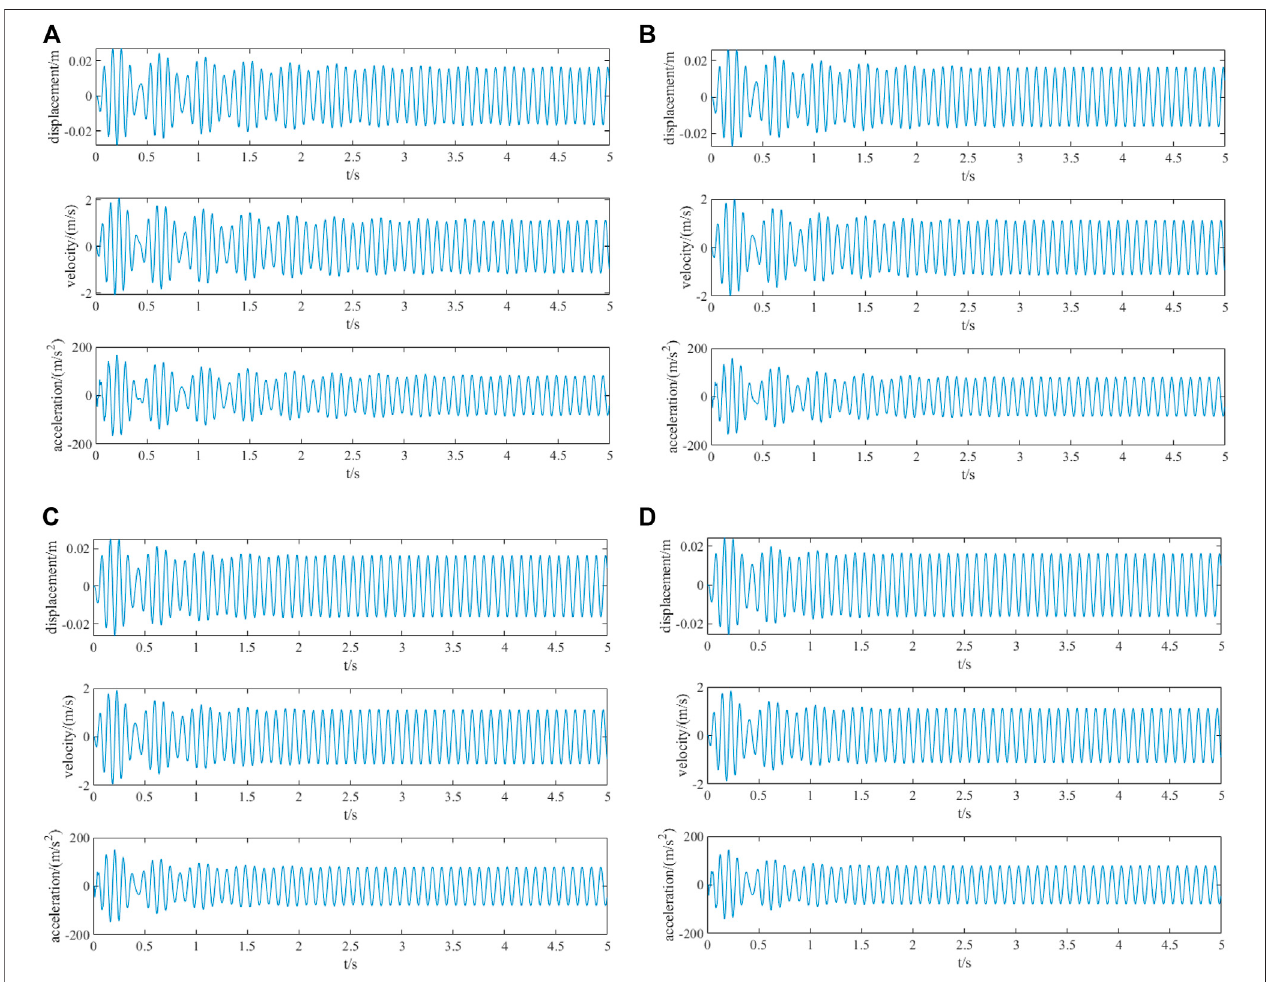
FIGURE 8 | (A) Time history curve of the output response under harmonic excitation (f = 11 Hz and ζ = 0.01). (B) Time history curve of the output response under harmonic excitation (f = 11 Hz and ζ = 0.015), (C) Time historycurveof the output response under harmonic excitation (f = 11 Hz and ζ = 0.02). (D) Time history curve of the output response under harmonic excitation (f = 11 Hz and ζ =